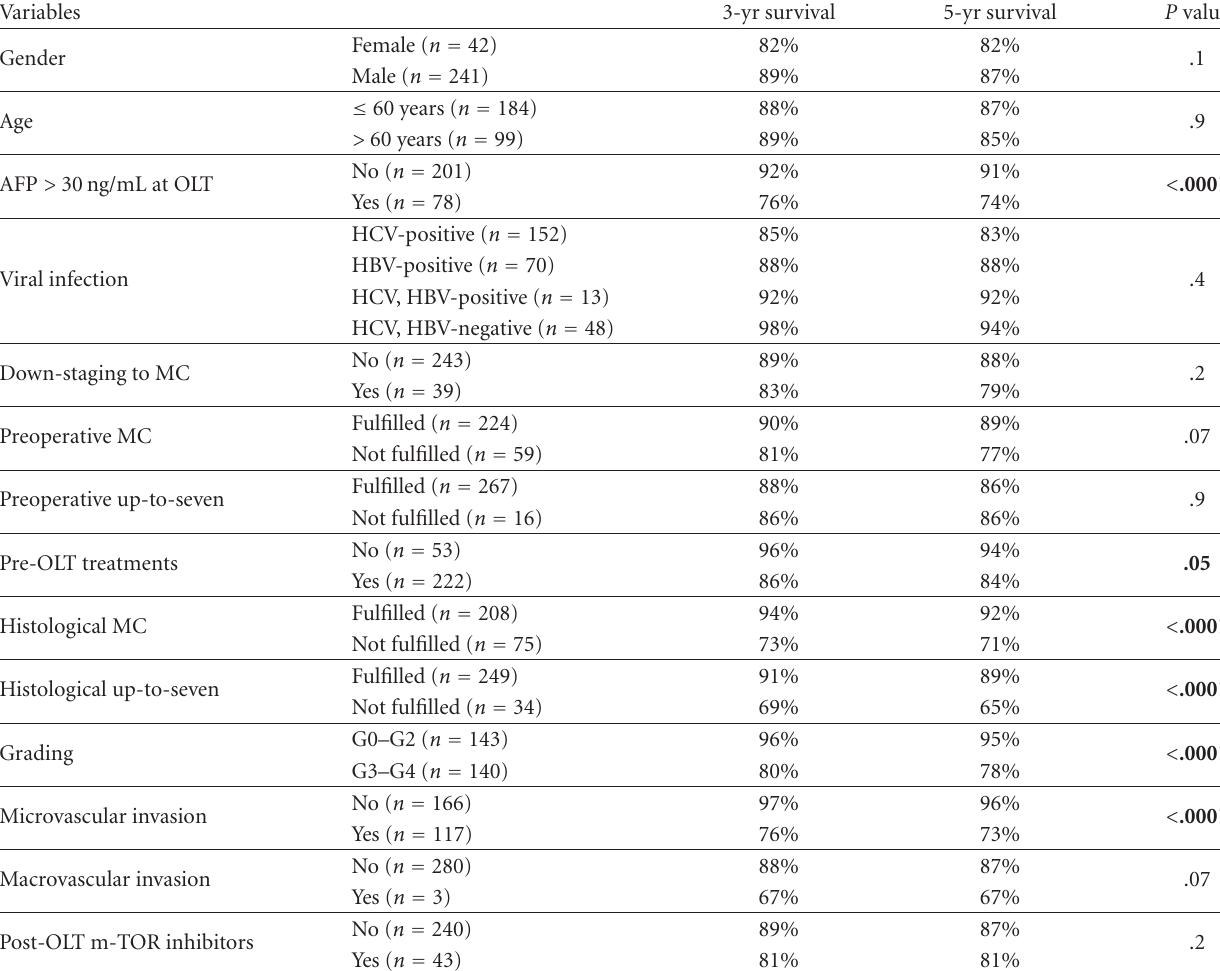
Table 2: Univariate analysis of factors a ff ecting recurrence-free survival after OLT in patients with HCC. Variables